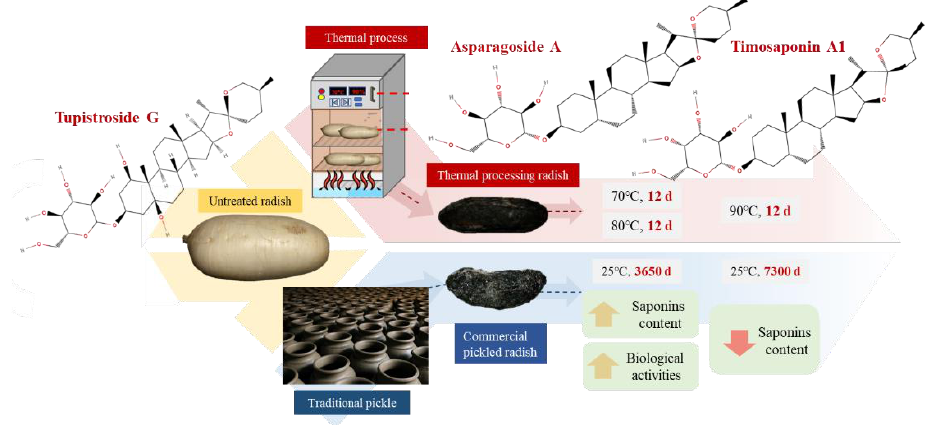
Figure 6. A summary of the methods and main findings of this study. The molecular formula was drawn by the author with MolView software. drawn by the author with MolView